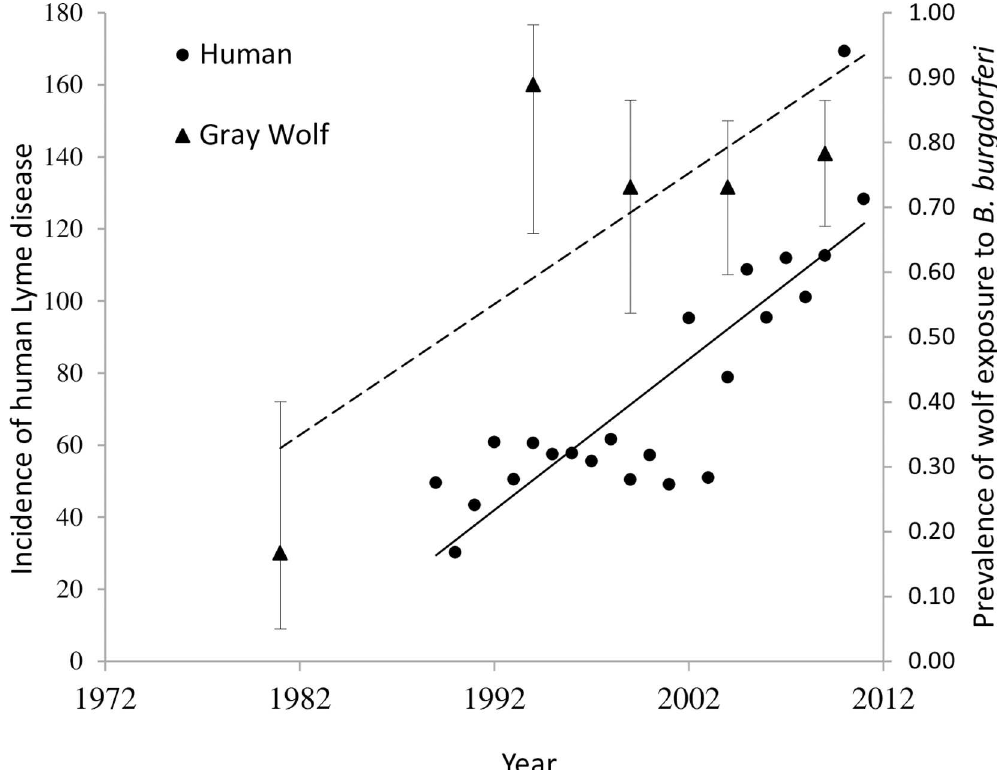
Fig 4. Seroprevalence of gray wolves to B . burgdorferi (Lyme disease) during 1985 to 2011, and incidence of human Lyme disease from 1989 through 2011, within spatial cluster of exposure located in northwestern Wisconsin. Wolf samples are groupedinto 5-year groups(1985–1990(n = 4), 1991–1996 (n = 18), 1997–2001 (n = 26), 2002–2006 (n = 52) and 2007–2011 (n = 69)). Data points represent the observed prevalence of wolf exposurewithin a period. Vertical bars represent 95% confidenceinterval(CI). Coefficient estimate = 0.07 (z = 1.71, P = 0.09, 95% CI = -0.01–0.15, OR = 1.07, CI = 0.99–1.17).For humanLyme diseaseincidencethe coefficient estimate = 4.18 (t = 7.067, P < 0.001, 95% CI =